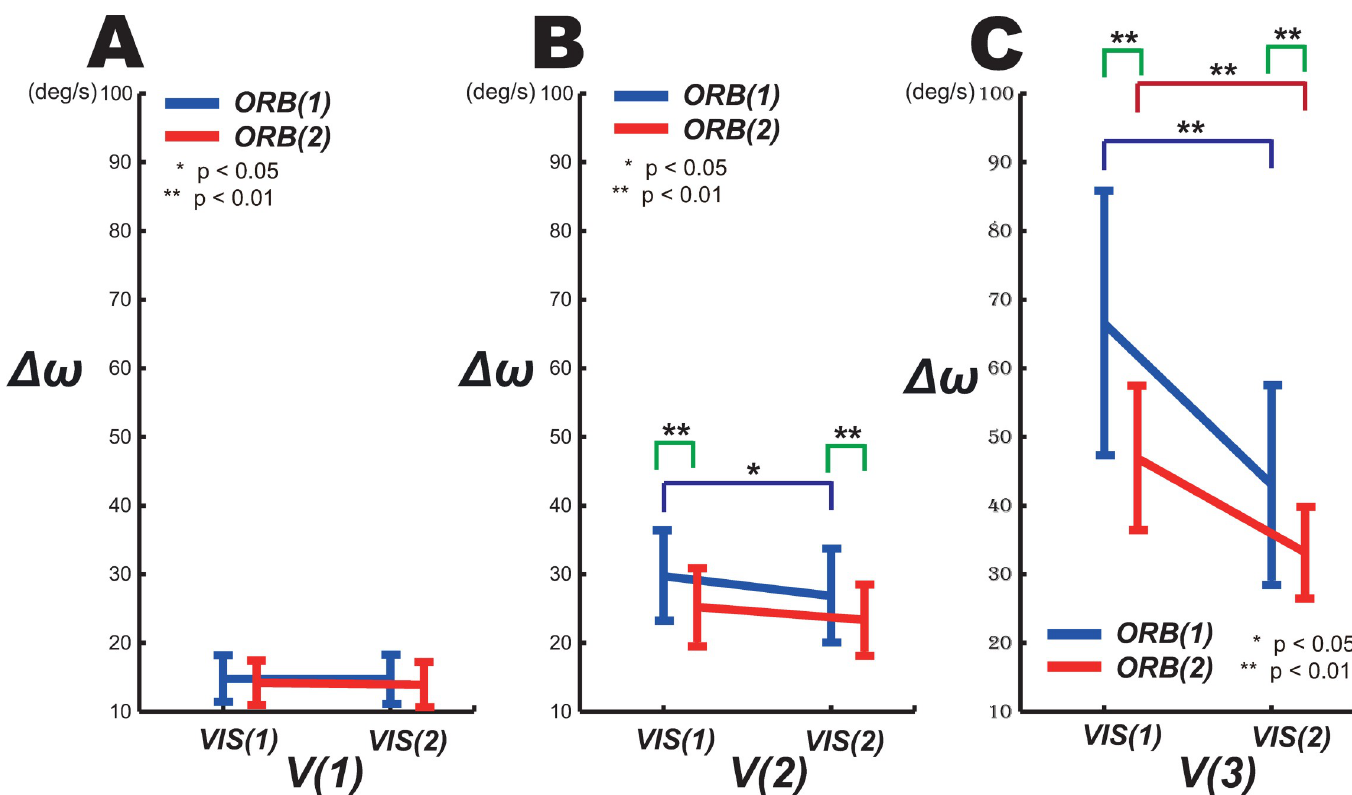
Fig 4. Effect of visuomotor control on Δ ω . For each ORB level, effects of VIS on Δ ω are shown at (A) 0.25, (B) 0.5, and (C) 0.75 Hz.